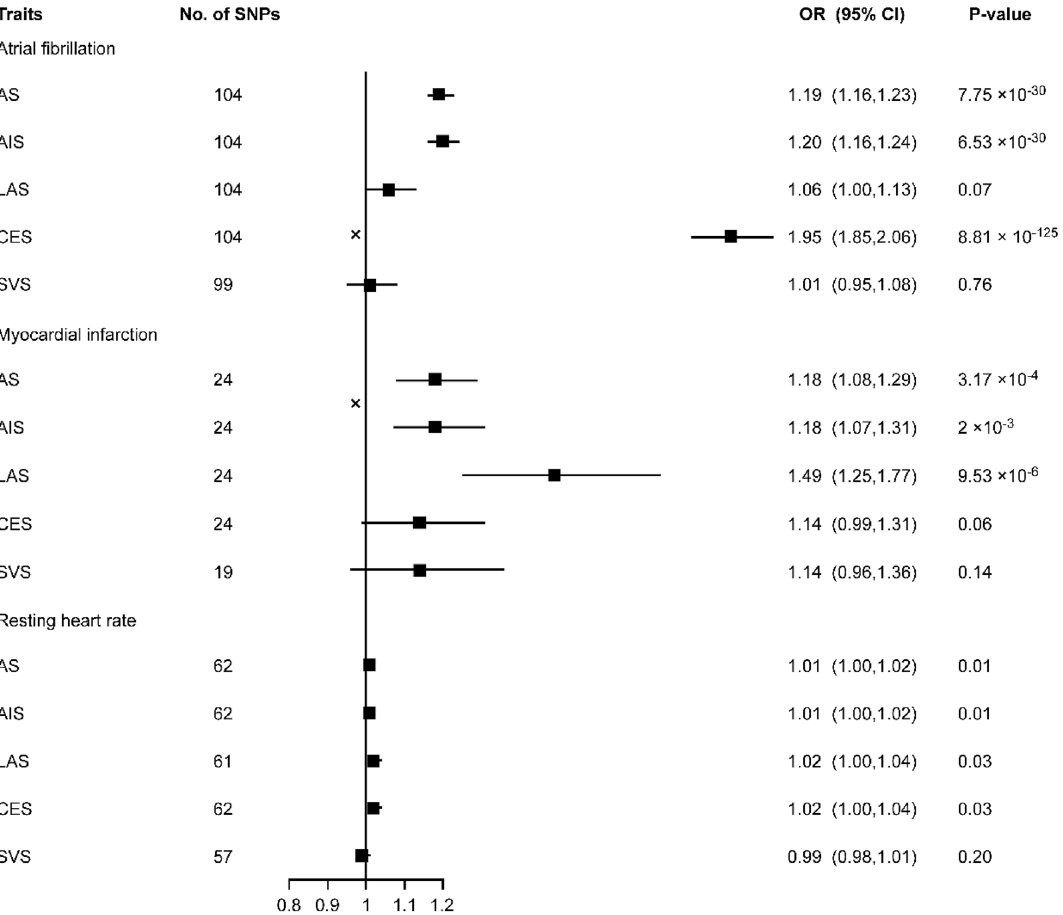
Figure 1. Mendelian randomization for associations between AF, MI, and RHR and stroke and its subtypes. AF atrial fibrillation, MI myocardial infarction, RHR resting heart rate, SNP single-nucleotide